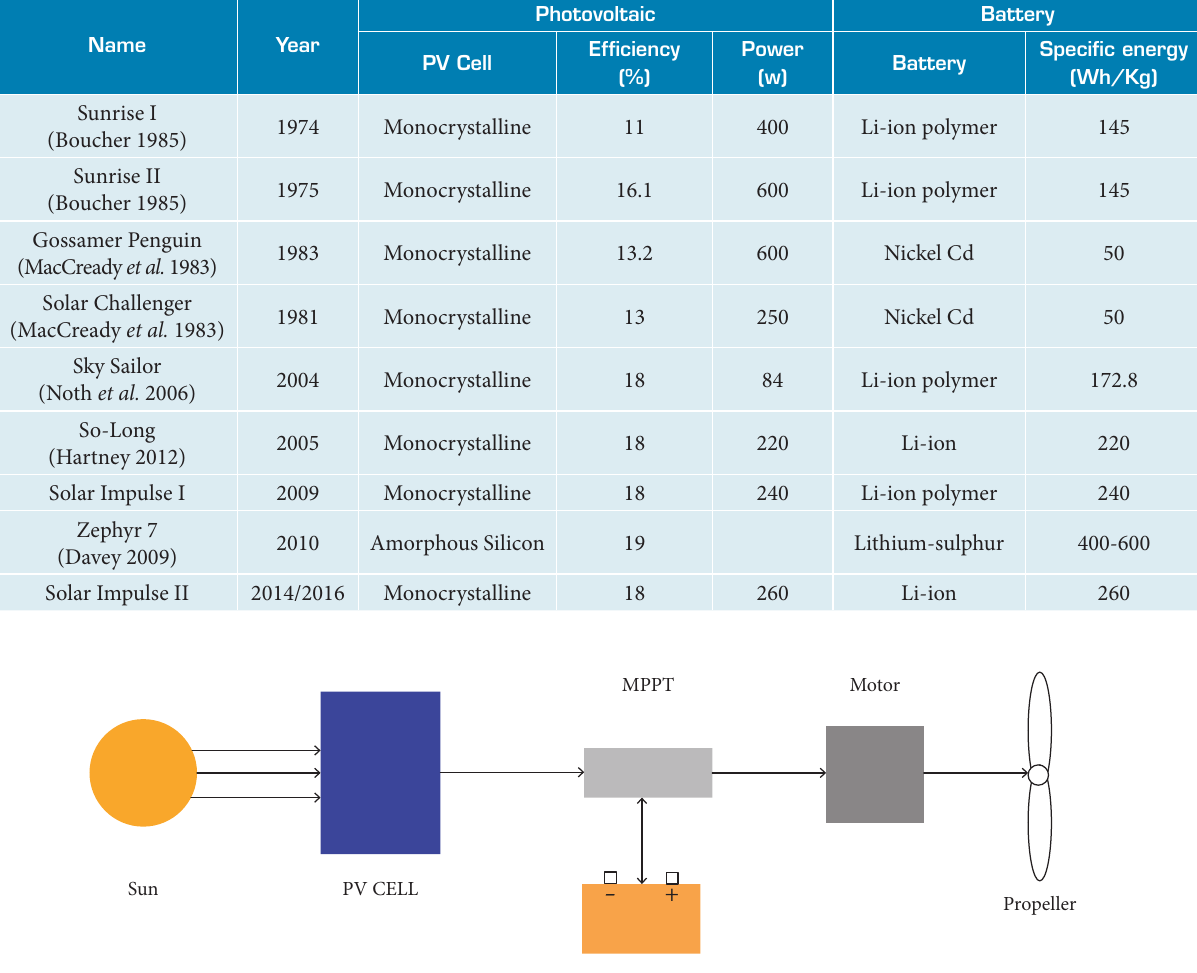
Table 2. Application and installation of different PV cells and batteries on solar-powered aircrafts.